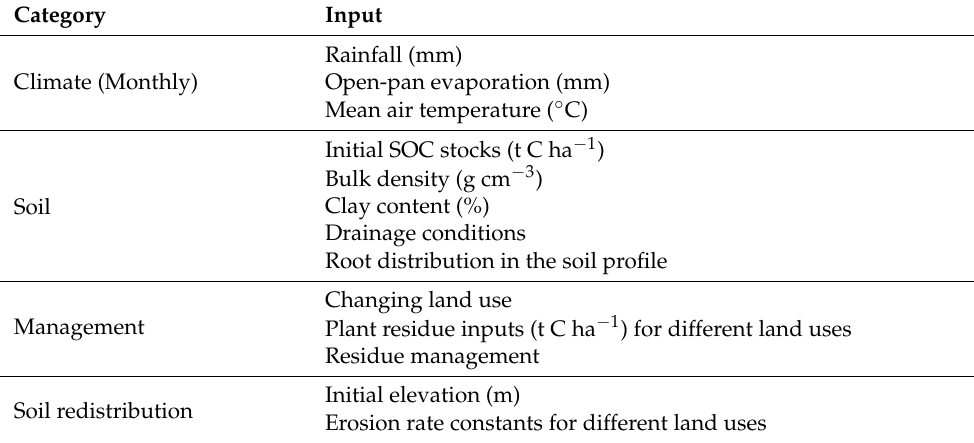
Table 1. Summary of inputs to the coupled